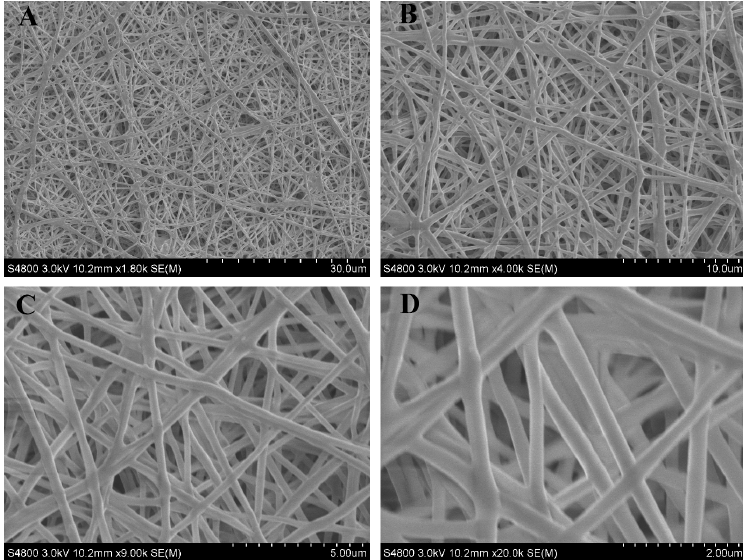
Figure 1. SEM images of the electrospun fibers of P1 ( A , C ) and P2 ( B , D ) show random orientation. ( A ) 30 µ m; ( B ) 10 µ m; ( C ) 5 µ m and ( D ) 2 µ m